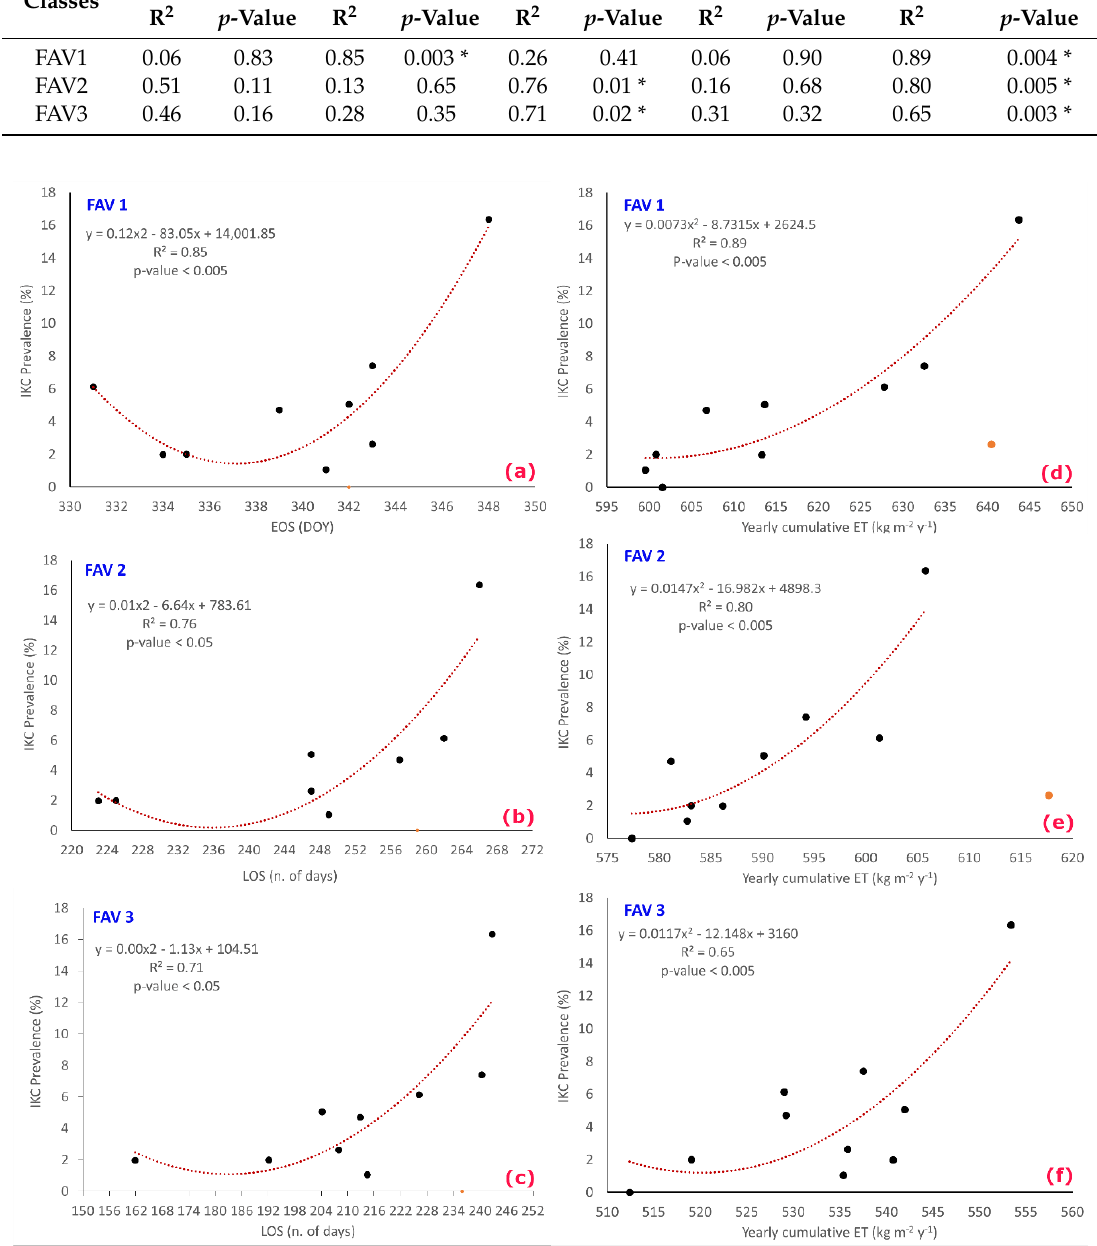
Figure 7. Graphs ( a – c ) show the most significant relationships that were recognized between IKC prevalence and PMs. ( a ) IKC Pr vs. EOS at FAV1; ( b ) IKC Pr vs. LOS at FAV2; ( c ) IKC Pr vs. LOS at FAV3. Graphs ( d – f ) show the most significant relationships that were recognized between IKC prevalence and ET (Cumulative yearly ET) values for FAV1, FAV2, and FAV3, respectively. In all the graphs, the red-orange points represent outliers (see Equation (3)).